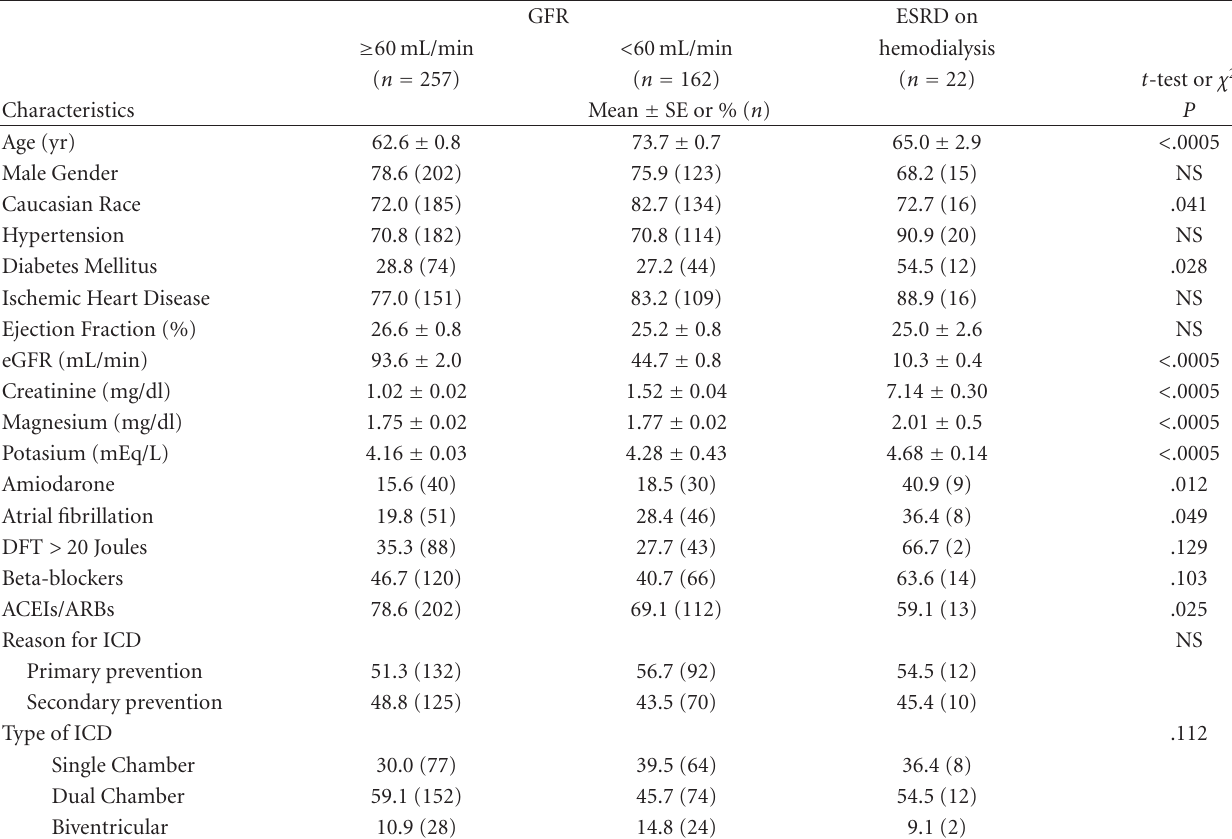
Table 1: Characteristics of the study population. Groups based on eGFR or being on